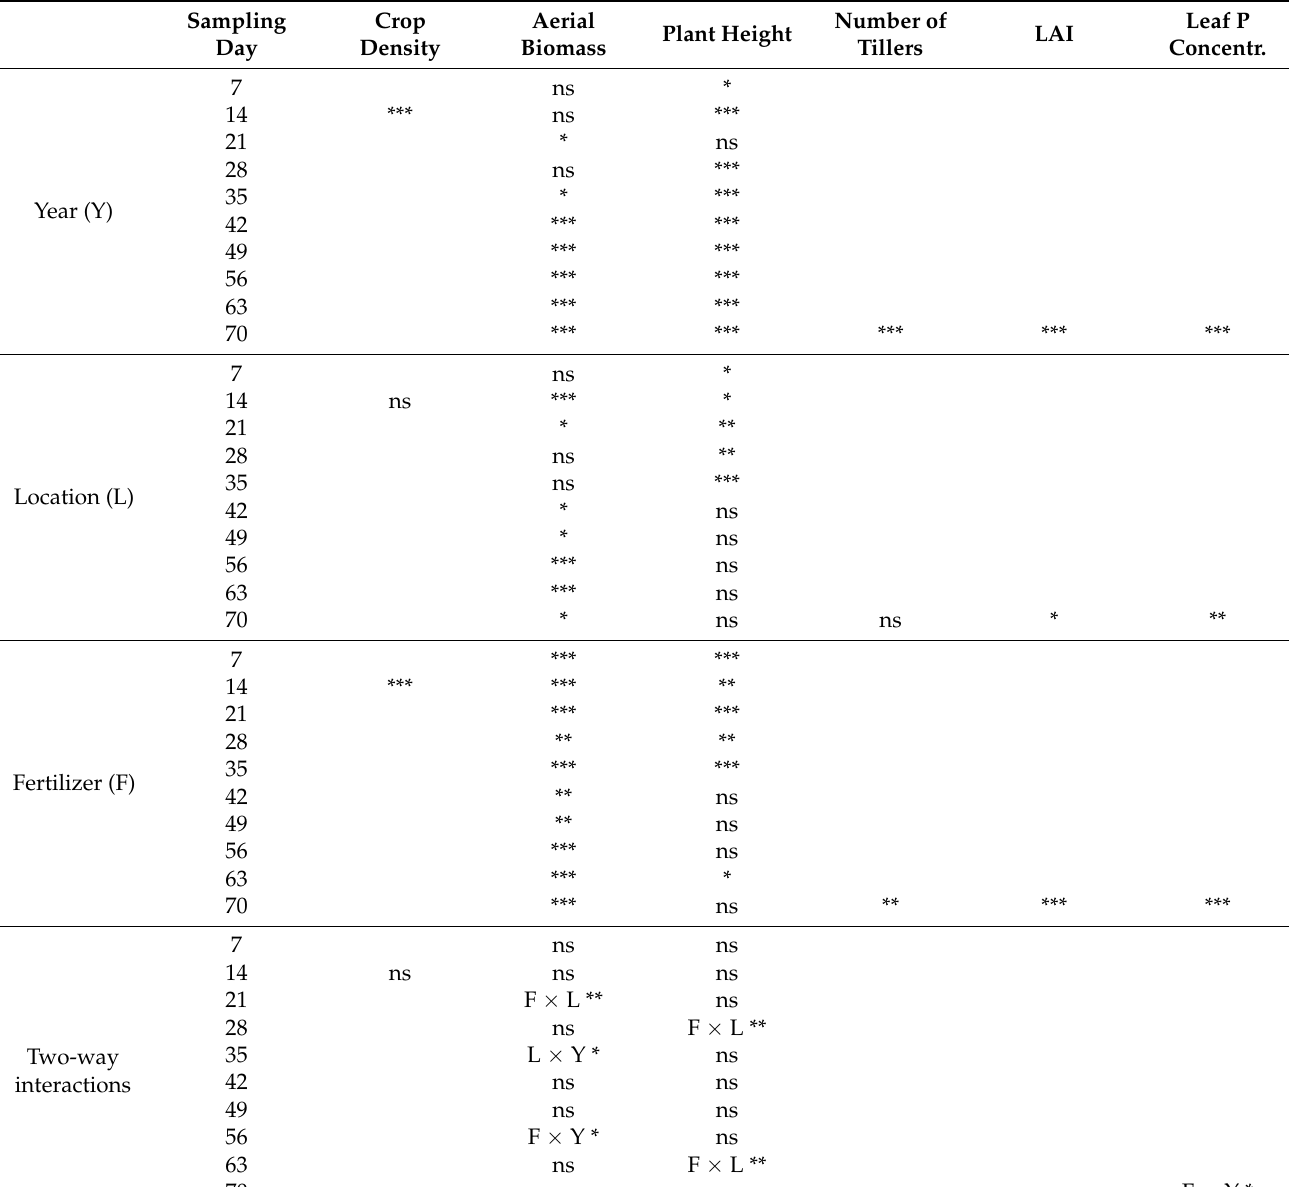
Table 2. Results from the analysis of variance for the recorded